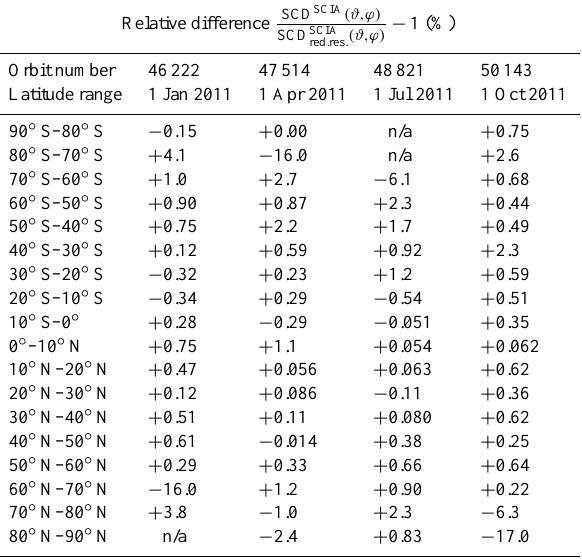
Table 2. Relative difference of original SCIAMACHY measure- ments SCD SCIA (ϑ,ϕ) and reduced-resolution SCIAMACHY mea- (ϑ,ϕ) for four exemplary orbits from the year surements SCD SCIA red.res. 2011.